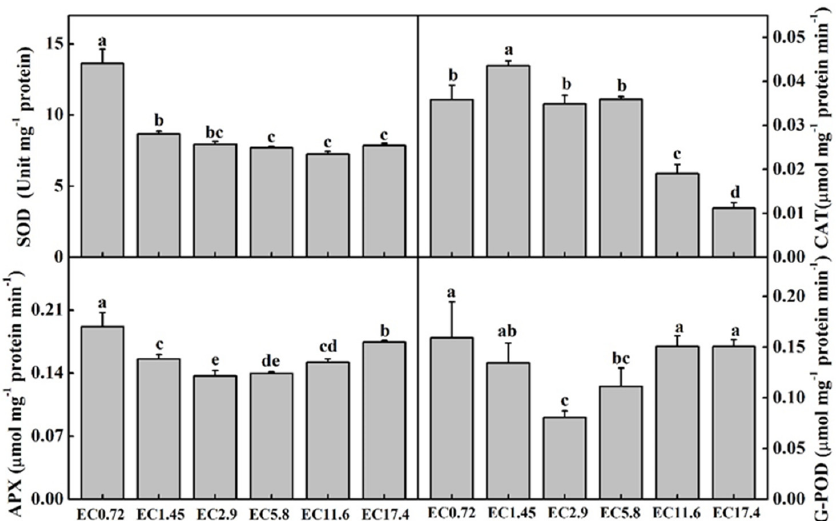
Figure 5. Effects of different EC treatments on the antioxidant enzyme activities of SOD, CAT, APX, and G-POD after 25 days of treatment. Data represent the mean ± SD ( n = 3). EC0.72, EC1.45, EC2.9, EC5.8, EC11.6, and EC17.4 represent the different nutrient solution electrical conductivities of 0.72 dS m −1 , 1.45 dS m −1 , 2.9 dS m −1 , 5.8 dS m −1 , 11.6 dS m −1 , and 17.4 dS m −1 . Data represent the mean ± SD ( n = 3). Different letters indicate significant differences at α = 0.05 based on the Least Significant Difference test. APX = ascorbate peroxidase; CAT = catalase; G-POD = guaiacol peroxidase; SOD = superoxide dismutase.